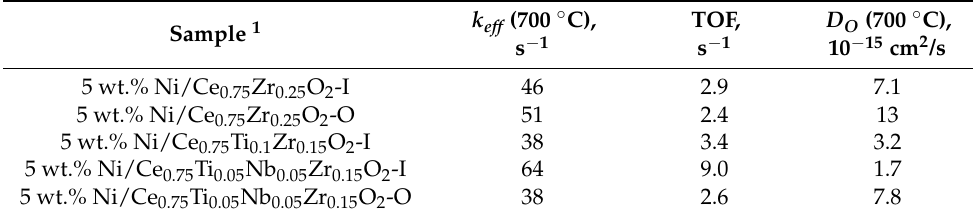
Table 2. Kinetic parameters of MDR and oxygen mobility for catalysts prepared in supercritical conditions